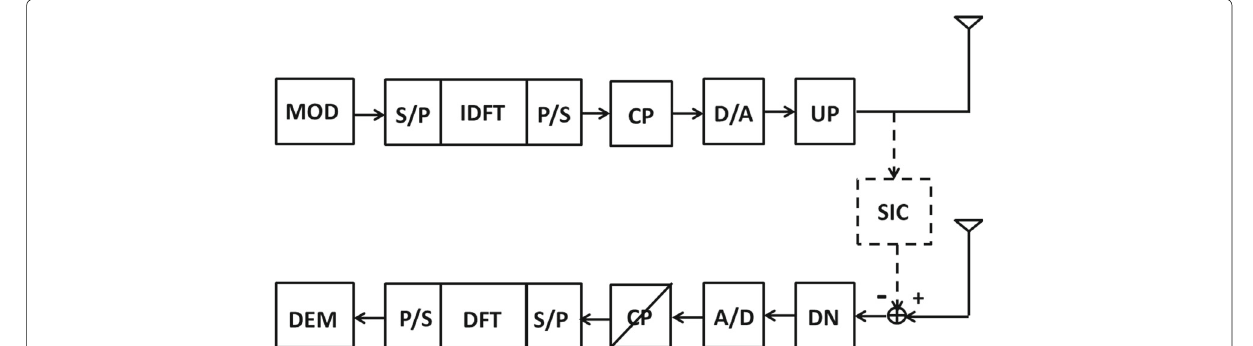
Fig. 1 FD transceiver. High-level block diagram of the FD transceiver with the SIC